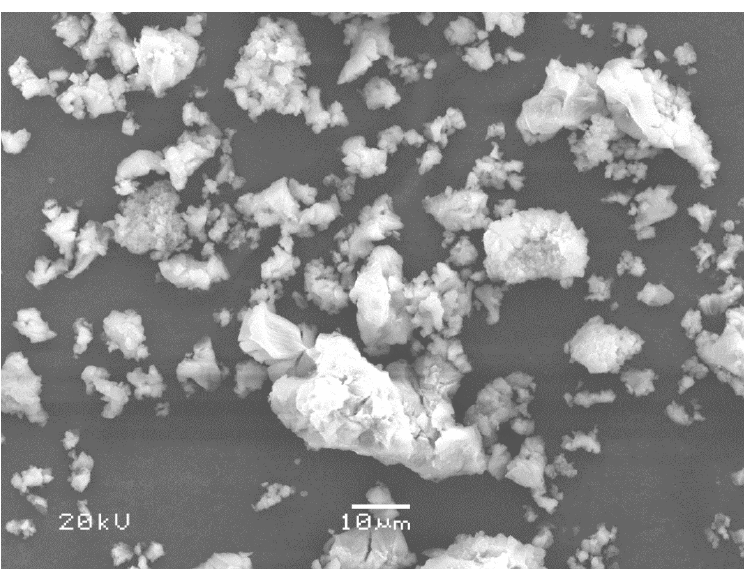
Figure 4. SEM images of calcium hydroxide at a magnification of 1000×.